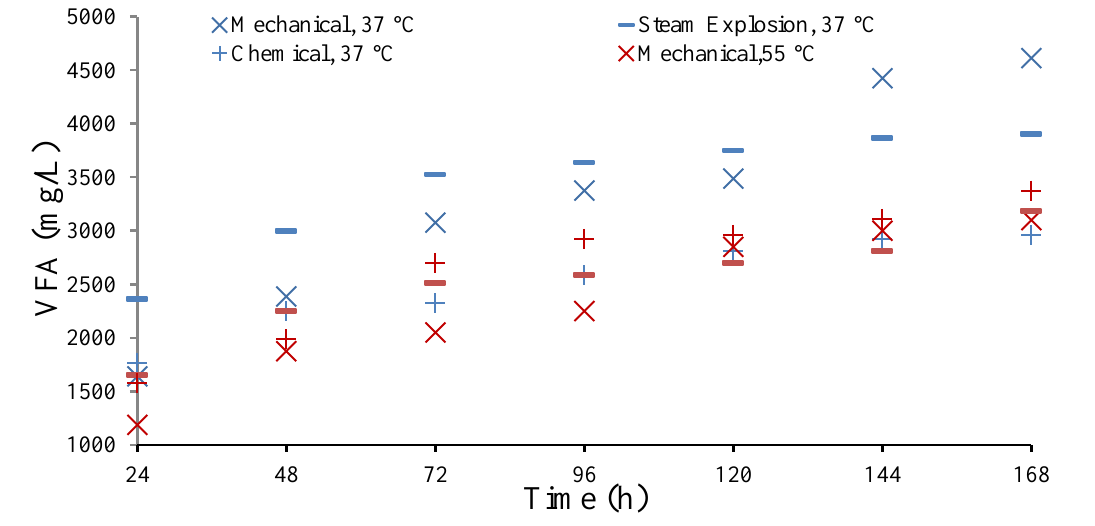
Figure 6. Volatile fatty acids (VFA) trend under various treatments.